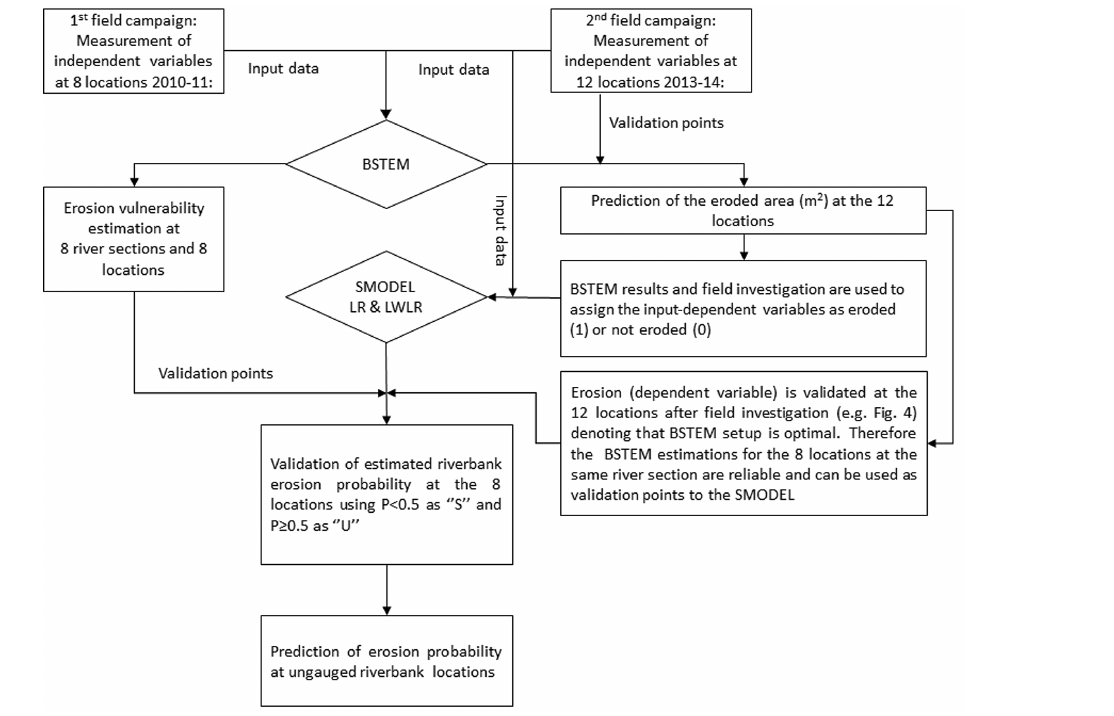
Figure 3. Process flowchart that presents the combined application of the BSTEM and of the proposed statistical model (SMODEL) based on LR principles. “S” and “U” correspond to stable and unstable riverbanks,